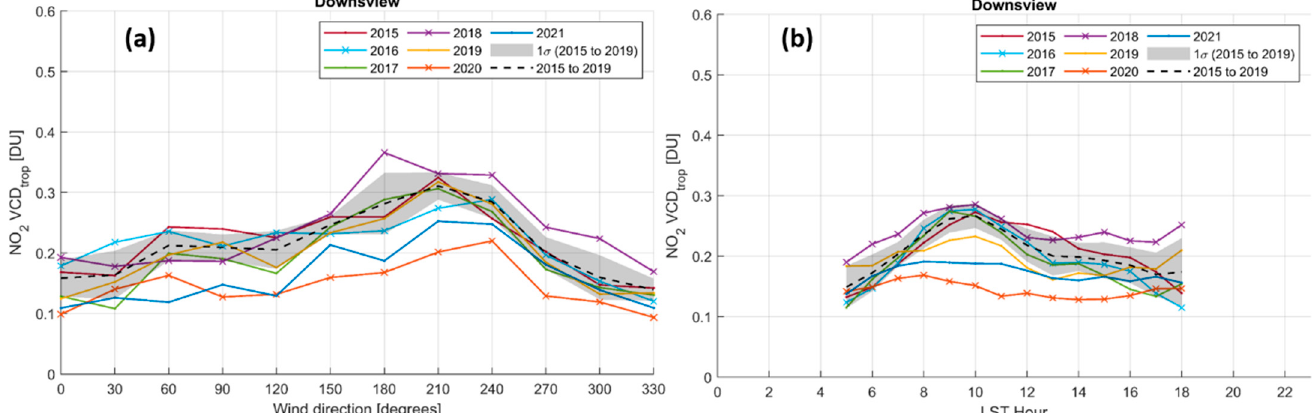
Figure 4. NO 2 tropospheric column at Downsview site binned by ( a ) wind directions; and ( b ) local standard time (LST) in hours for observations from 15 March to 15 September of each year. The black dashed line is the mean of observations from 2015 to 2019, with the shading area representing the standard deviation of the 5-year mean.